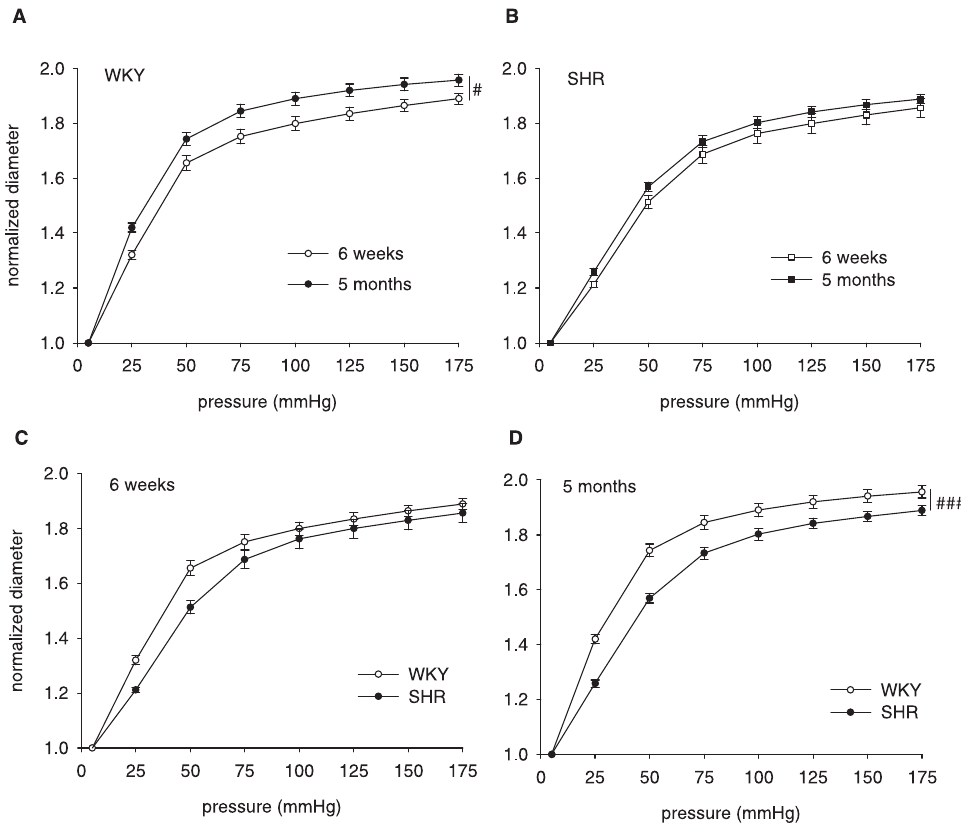
Figure 2. Vascular distensibility. Diameters were measured on cannulated mesenteric arteries, under fully dilated conditions. Diameters are normalized to the lowest pressure level to eliminate differences in vessel size. Panel A: WKY vessels show an increase in distensibility with maturation (5 months vs. 6 weeks), whereas SHR vessels do not (panel B). Panel C shows that at 6 weeks of age, distensibility of SHR vessels tends to be lower than vessels from WKY, but does not reach statistical significance. Panel D shows that at 5 months of age, SHR vessels are less distensible than WKY vessels. Data from individual sublines are shown in Figure S1. Data are mean 6 SEM, with WKY 6w: n=15 and 5 mo: n=17; SHR 6w: n=16 and 5 mo: n=16. # Indicates P , 0.05, and ### P , 0.001.